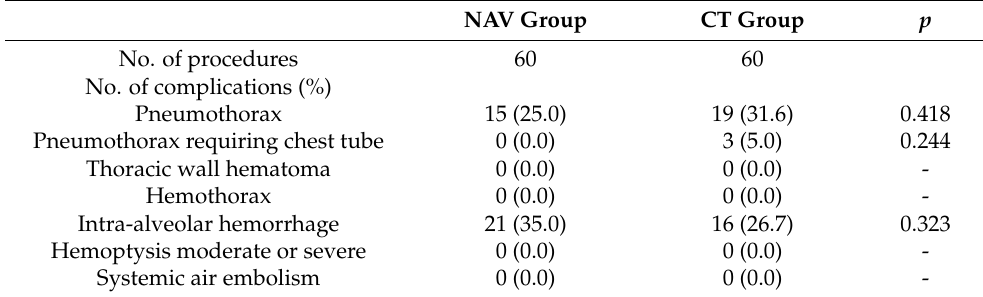
Table 5. Peri-procedural